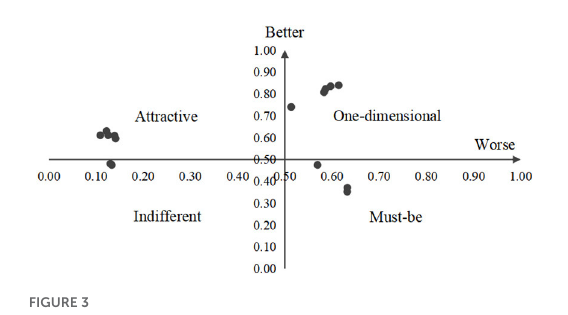
FIGURE2 Distribution of participants’ chronic disease types.